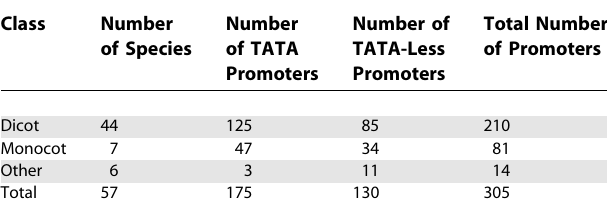
Table 2. The Numbers of Pol II Promoter Sequences from Different Species Included in the Training Set for Plant Models